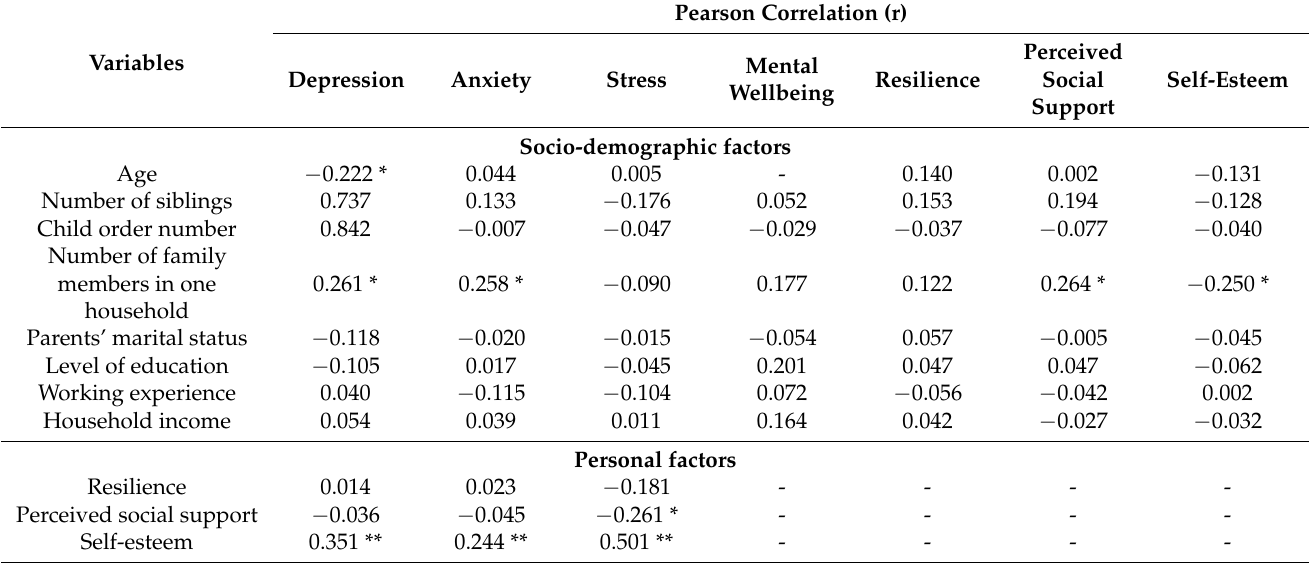
Table 5. Correlation analysis between socio-demographic factors and personal factors with dependent variables of